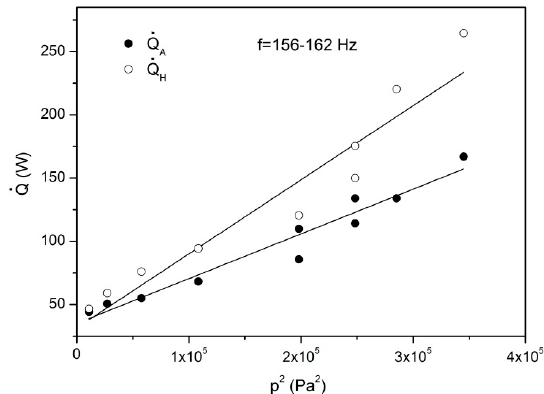
Figure 9 . The heat introduced by the heater and extracted by the ambient heat exchanger with rectangular pores as a function of the square of the acoustic pressure.